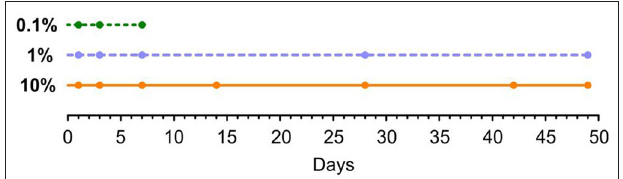
FIGURE 3 | Time points of perilymph sampling for three different dexamethasone concentrations: 0.1, 1, and 10%. All animals were implanted at day